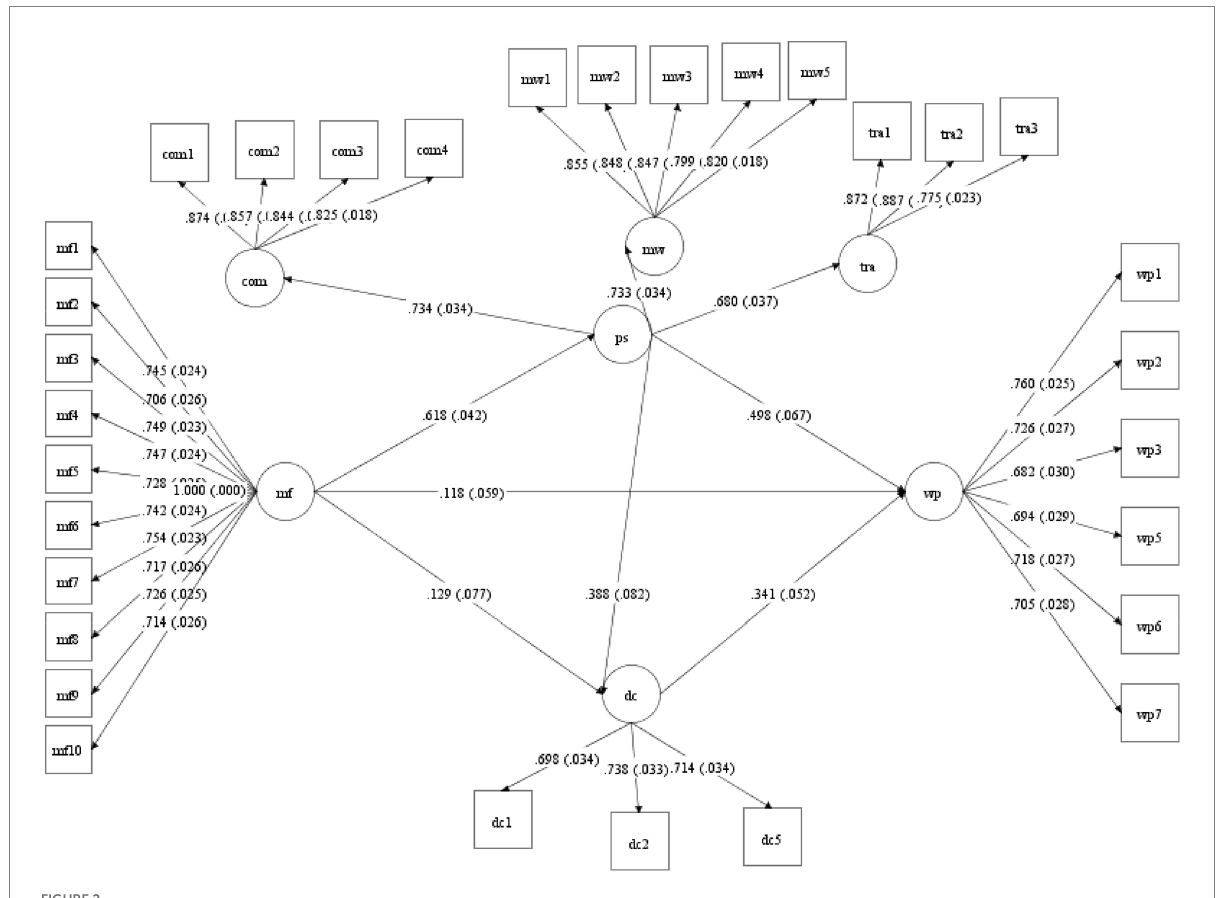
FIGURE 2 The output of the structural equation